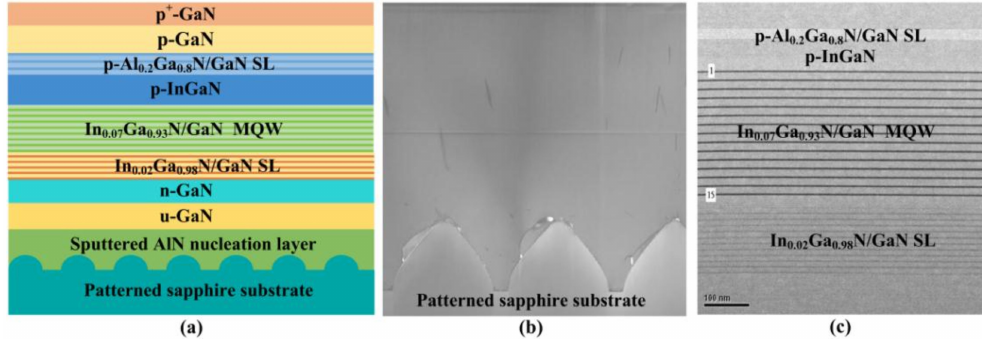
Figure 1. ( a ) Schematic representation of the UV LED epitaxial structure; ( b ) cross-sectional TEM image of the UV LED epitaxial structure; ( c ) magnified cross-sectional TEM image showing In 0.02 Ga 0.98 N/GaN SL, In 0.07 Ga 0.93 N/GaN MQW, and p-Al 0.2 Ga 0.8 N /GaN